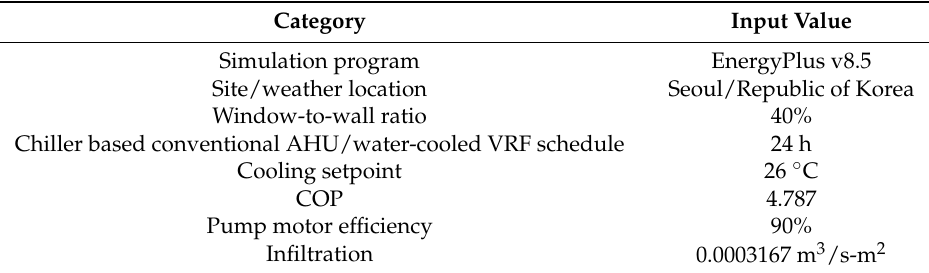
Table 6. Simulation conditions.